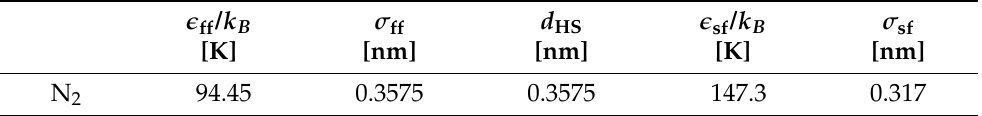
Figure 2. Comparison between experiments [62] and the cDFT simulations for the adsorption isotherm of N 2 in a SiO 2 slit pore with a width of L = 500 σ ff . The chosen wall potential does not fully capture the interactions between N 2 and SiO 2 , but the results show a good match. This confirms that the used parameters shown in Table 1 are a reasonable choice. Table 1. cDFT parameters of N 2 and SiO 2 [60]. The number density for SiO 2 is ρ s = 66.15 nm − 3 [35]. Fluid-fluid interactions are truncated at 5 σ ff . The simulations are performed at 77.3